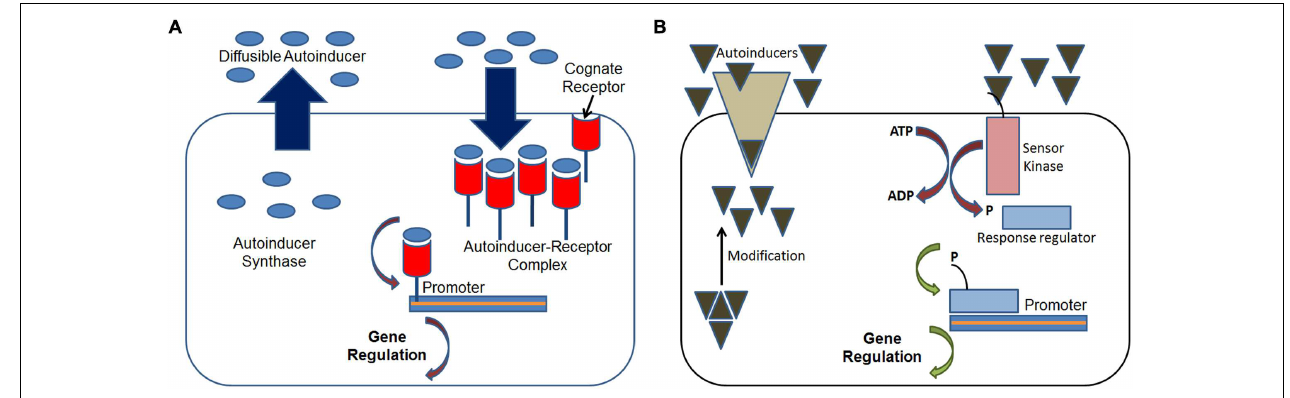
FIGURE 1 | Schematics of quorum sensing systems in bacteria. (A) Gram-negative bacteria: at threshold concentrations the diffusible autoinducer signaling molecule, typically a homoserine lactone, binds to its cognate receptor inside the cell forming the autoinducer-receptor complex which then regulates the expression of target genes through its binding to the target promoter; and (B) Gram-positive bacteria: at threshold concentrations the autoinducer peptide molecule which is actively transported activates the sensor kinase protein inside the cell which phosphorylates the response regulator protein, which then regulates the expression of target genes through its binding to the target promoter. Adapted from Koh et al.